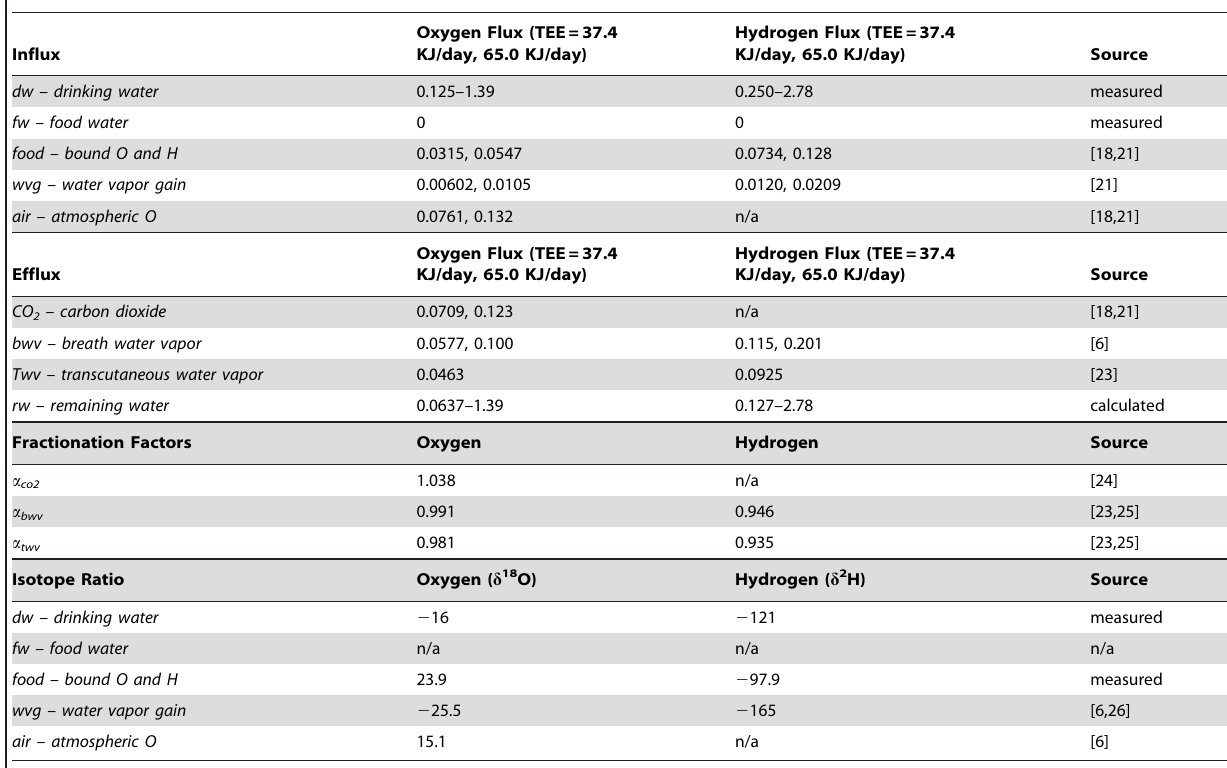
Table 1. Values used in body water